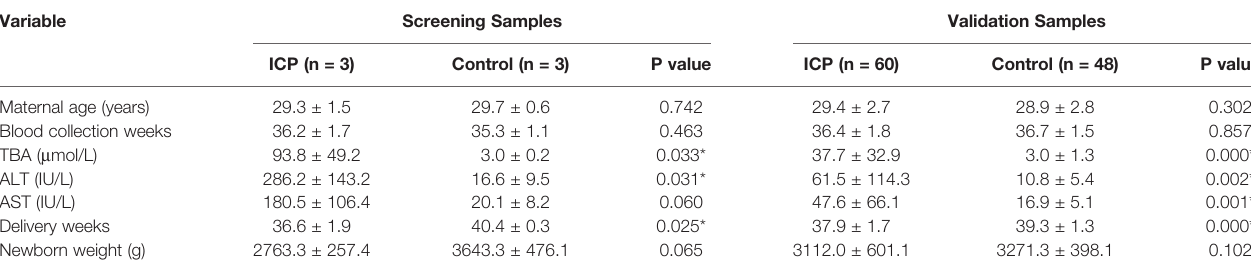
TABLE 2 | Clinical characteristics of pregnant women with ICP and healthy pregnant controls. Variable Screening